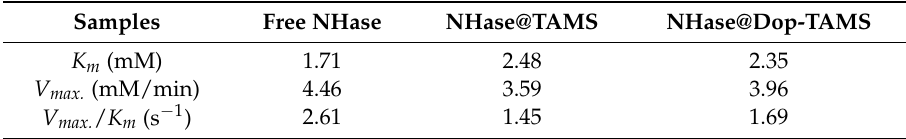
Table 2. Kinetic parameters of free and immobilised NHase.